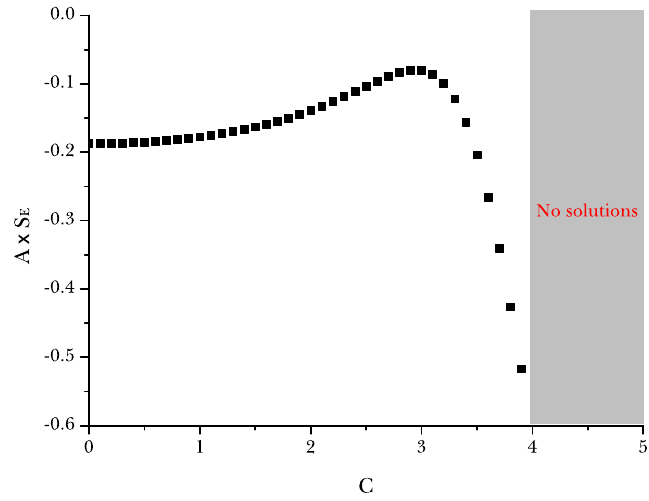
Figure 3. Euclidean action for exponential potential. If C > 4, classicalized solutions are not allowed